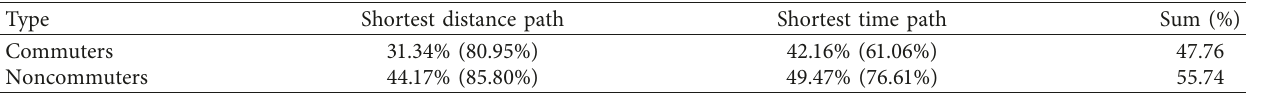
Table 8: Shortest path selection proportions for commuters and noncommuters on a working day.